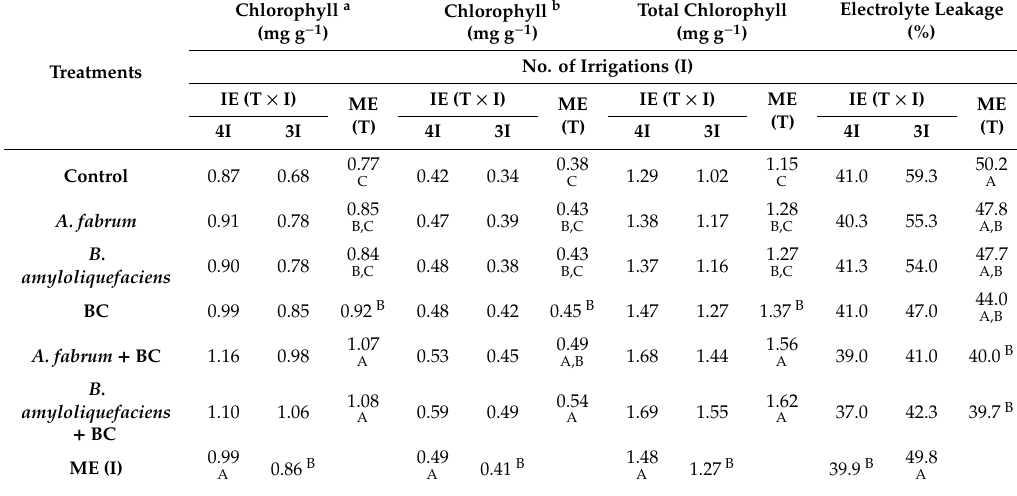
Table 7. E ff ect of Agrobacterium fabrum , Bacillus amyloliquefaciens with / without biochar (30 Mg ha − 1 ) on photosynthetic pigments synthesis in wheat leaves cultivated in drought-stressed field conditions *.